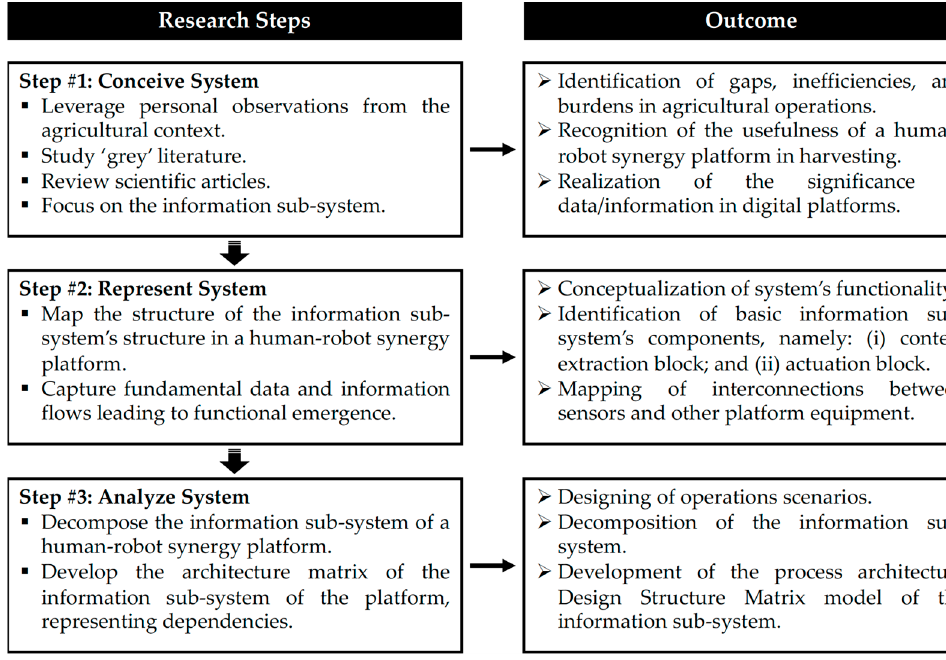
Figure 1. Research process flowchart.